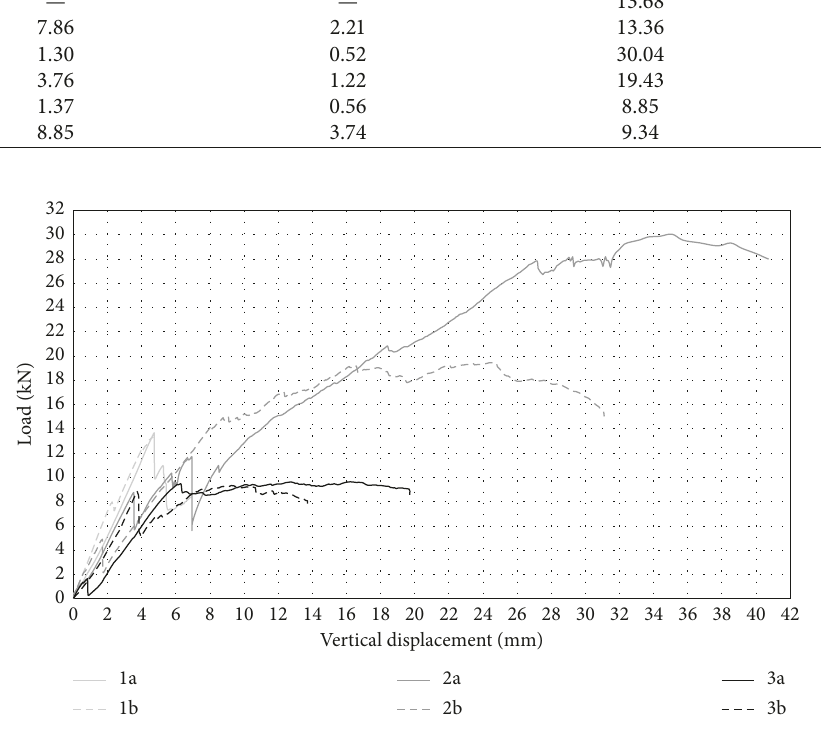
Figure 5: Experimental load-displacement curves.